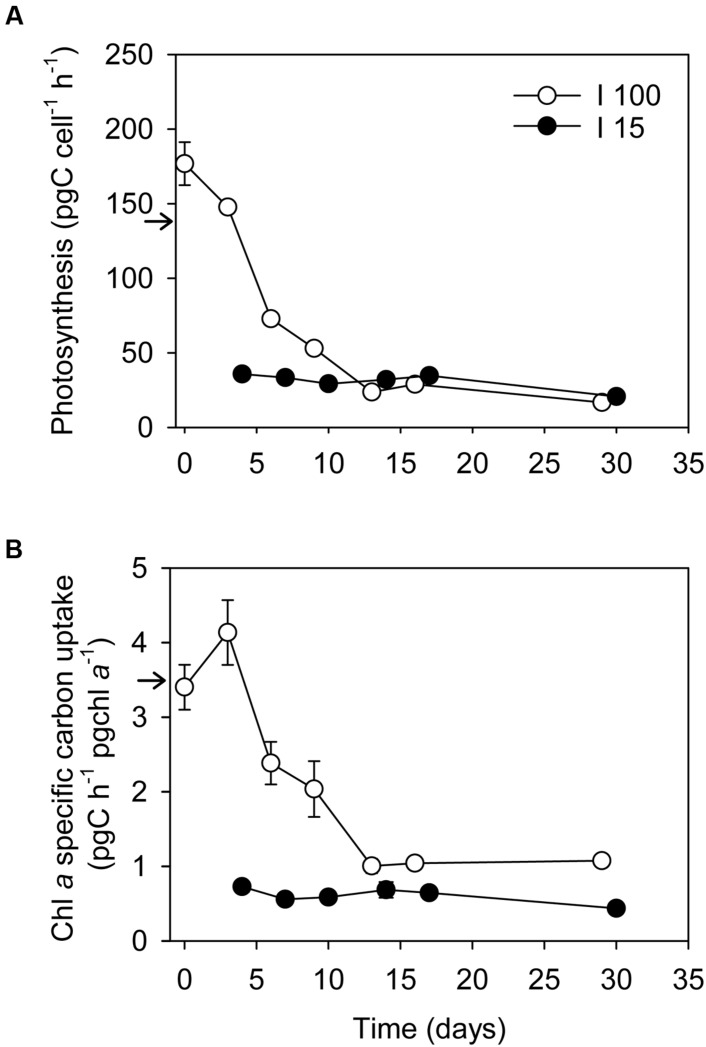
Changes in (A) Cellular inorganic carbon uptake (pg C cell-1 h-1), and (B) Chl a-specific inorganic carbon uptake (pg C pg Chl a-1 h-1) in D. acuta during the prey starvation experiment at two irradiances, I100(o) and I15(●), respectively. Data points represent treatment means and error bars indicate standard errors (n = 3). Arrows indicate values from well fed cultures for comparison.